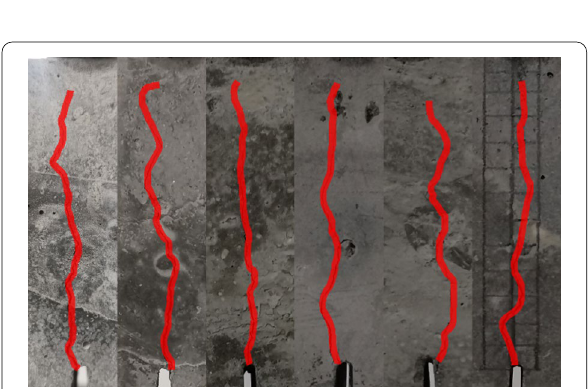
Fig. 6 Experimental crack propagation paths for the six specimens in the same